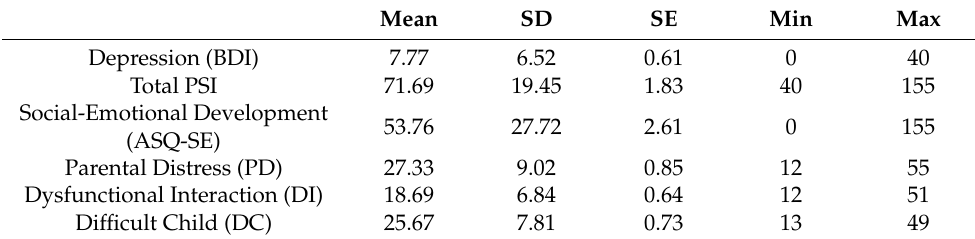
Table 2. Means (Standard Deviations) for maternal and child